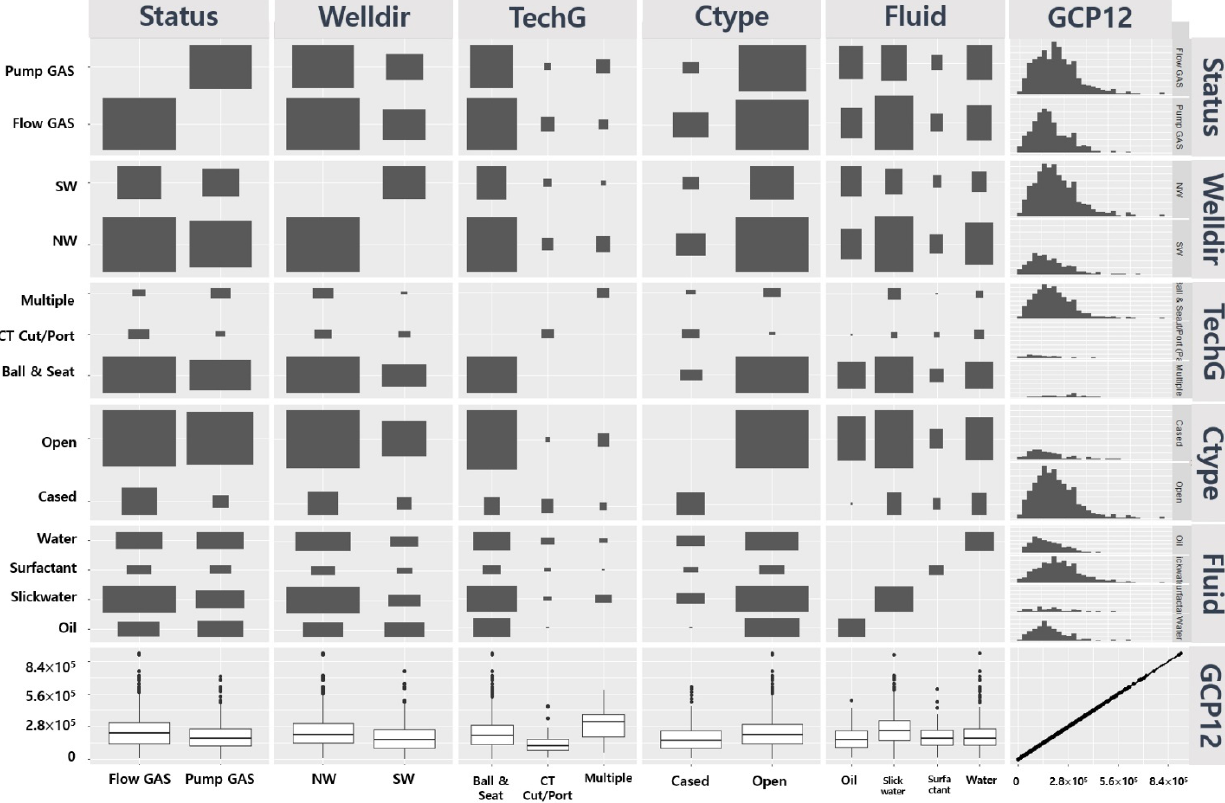
Figure 5. Matrix plot showing the data distribution and histograms of categorical variables.